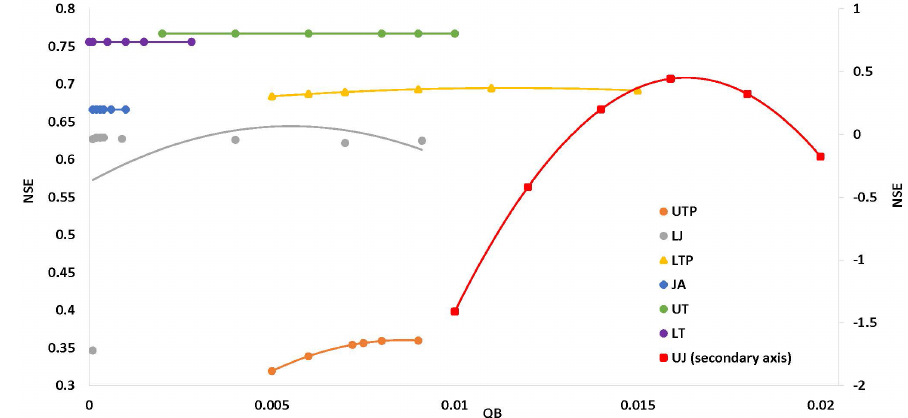
Figure 6. Model sensitivity to the initial conditions of baseflow (QB) for the different ED2 + R sub-basins in the domain: Upper Juruena (UJ); Upper Teles Pires (UTP); Lower Juruena (LJ); Lower Teles Pires (LTP); Upper Tapajós (UT); Jamanxim (JA); and Lower Tapajós